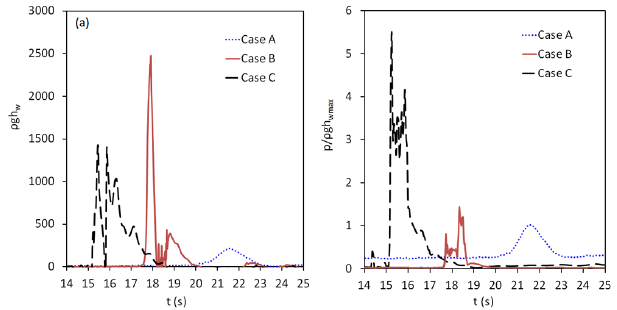
Fig. 11. Pressure time histories due to wave impact on the wall (obtained from the SPH simulations): (a) hydrostatic pressure es- timated from wave run-up height on wall, (b) impact